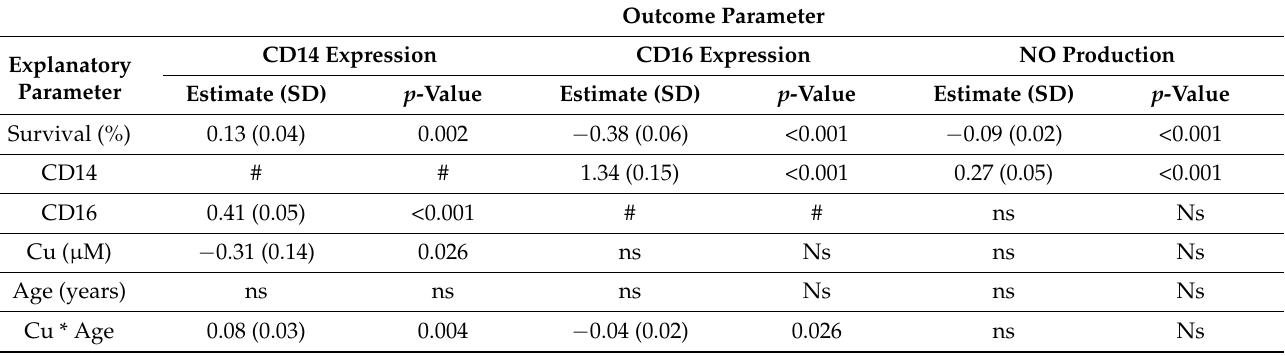
Table 2. Associations reported by the backwards stepwise multivariate mixed linear model of CD14/16 expression and Nitric oxide (NO) production of the PBMCs from five dairy cows under varying copper (Cu) levels (0–16 μ M). The estimates represent the slope of the linear regression line.